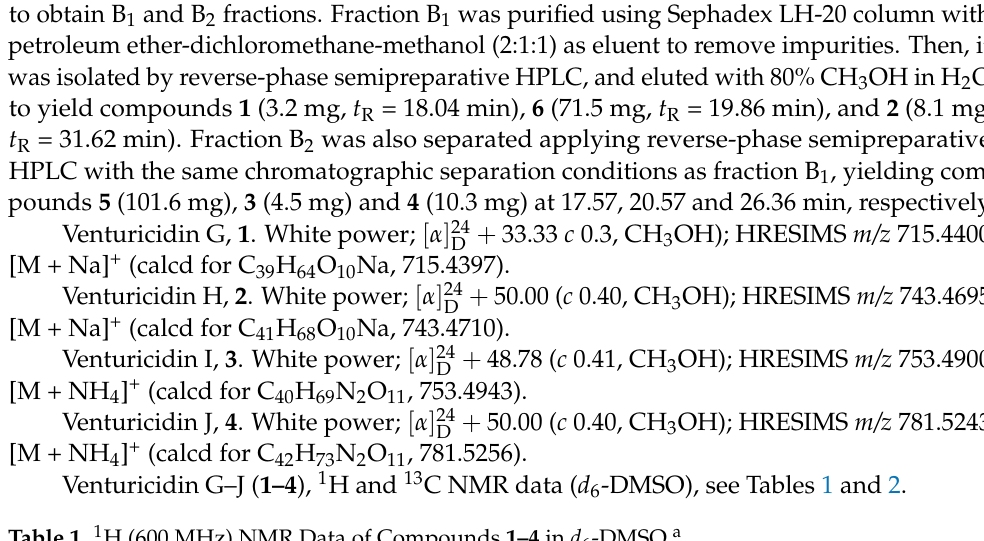
Table 1. 1 H (600 MHz) NMR Data of Compounds 1–4 in d 6 -DMSO a .